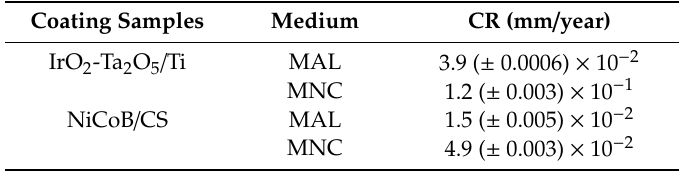
Table 2. Corrosion rate for the NiCoB / CS and IrO 2 -Ta 2 O 5 / Ti coatings. Table 1 . Corrosion rate for the NiCoB/CS and IrO 2 -Ta 2 O 5 /Ti coatings.